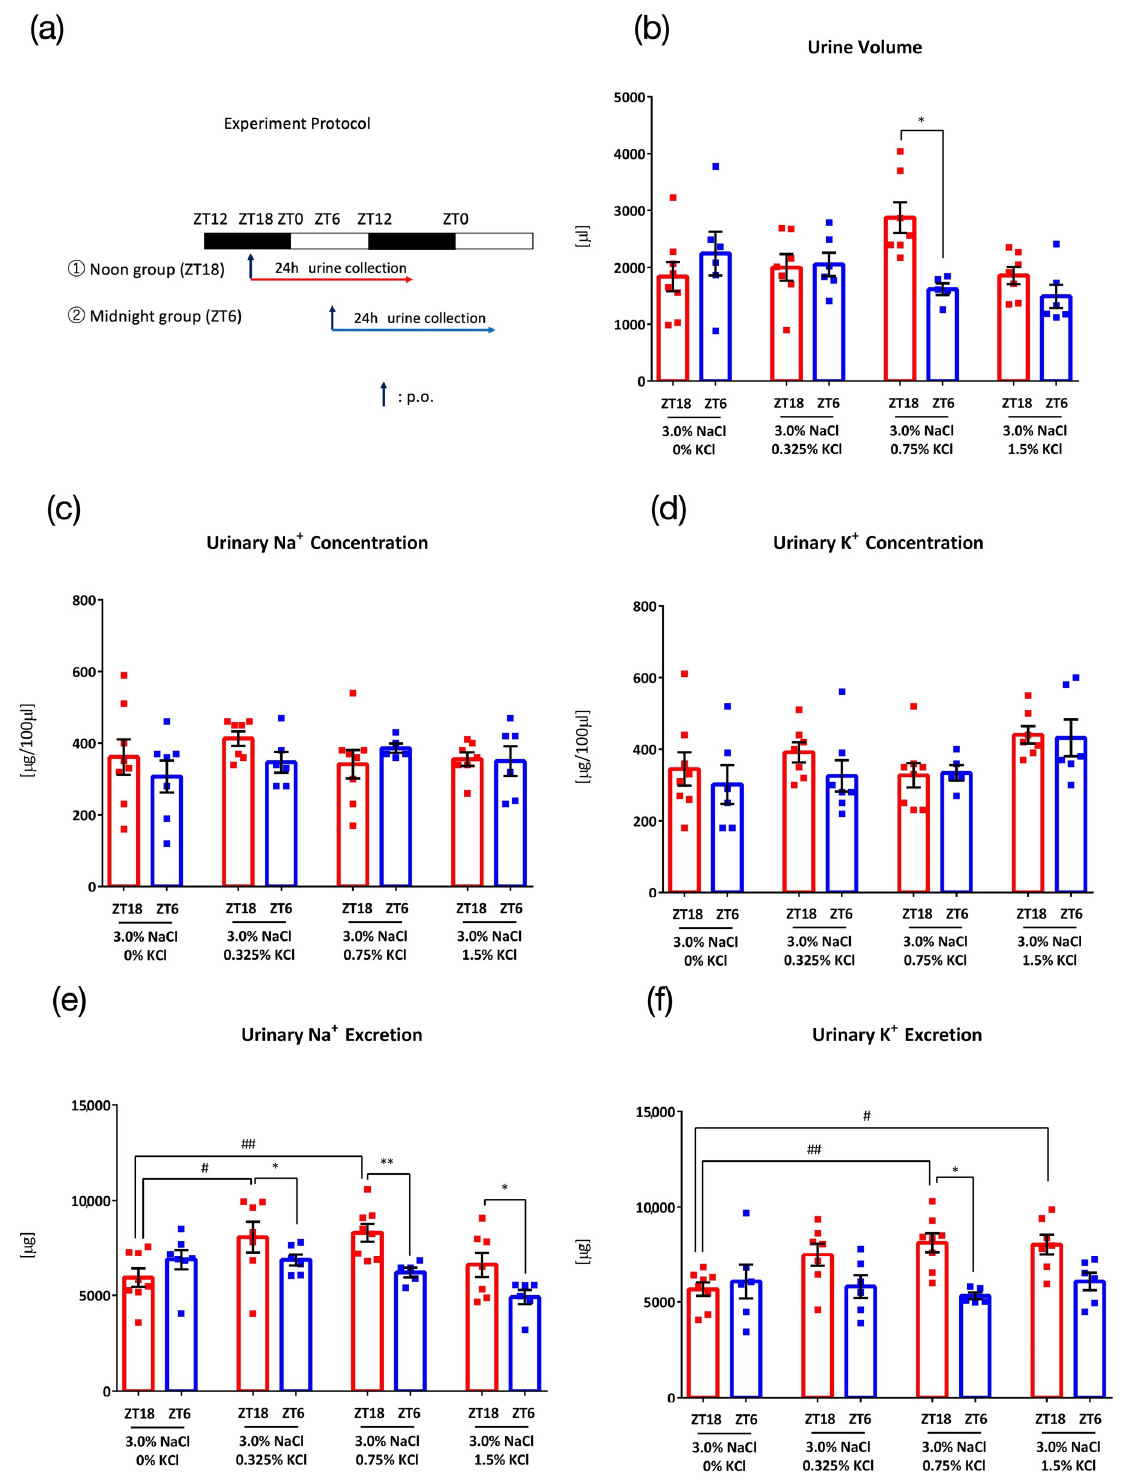
Figure 3. Urinary excretion after administration of salt load of different KCl concentrations against 3.0% NaCl. ( a ) Experimental protocol, ( b ) Urine volume, * p < 0.05 (vs. ZT6) Sidak. ( c ) Urinary Na + concentration, ( d ) Urinary K + concentration, ( e ) Urinary Na + excretion, * p < 0.05, ** p < 0.01 (vs. ZT6), # p < 0.05, ## p < 0.01 (vs. 3.0% NaCl, 0% KCl) Benjamini, Krieger and Yekutieli’s Two-stage. ( f ) Urinary K + excretion, * p < 0.05 (vs. ZT6), # p < 0.05, ## p < 0.01 (vs. 3.0% NaCl, 0% KCl) Sidak. Data are represented as mean ± SEM (ZT18 group: n = 7 – 8, ZT6 group: n = 5 – 6) .